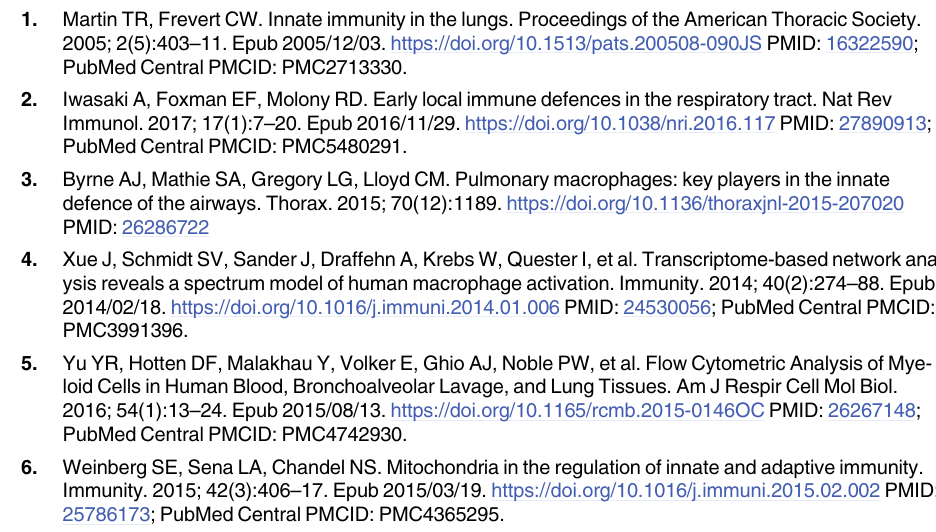
S2 Table. Concentrations of mediators secreted by hMDMs in pg/mL were measured using multiplex ELISA. Concentrations are reported as mean (standard error). n = 4 subjects (1 male, 3 females). a at least p < 0.05 in comparison with M0; b at least p < 0.05 in comparison with M1; c at least p < 0.05 in comparison with M2 by either one-way ANOVA with Tukey’s multiple comparisons test or Friedman test with Dunn’s multiple comparisons